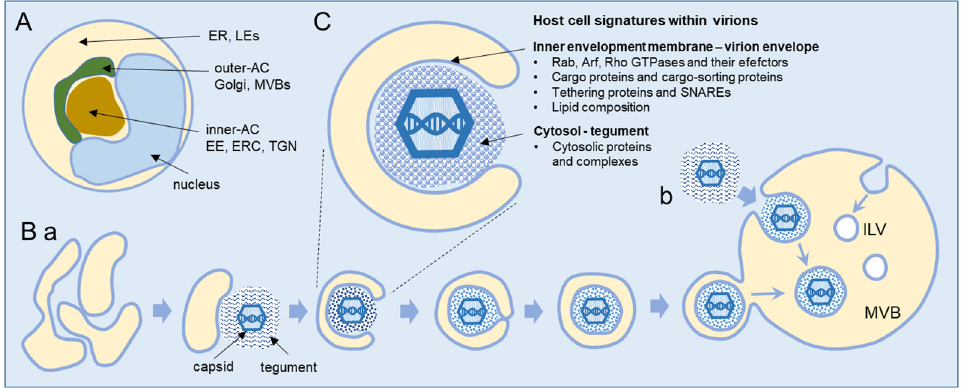
Figure 1. Schematic outline of the beta ‐ herpesvirus secondary envelopment. ( A ) Schematic presen ‐ tation of the infected cell and the AC. ( B ) Suggested sequence of HCMV cytoplasmic maturation in human foreskin fibroblasts recorded by advanced electron microscopy [2,34]. Secondary envelop ‐ ment occurs when partially tegumented capsids contact the membranous compartment. This con ‐ tact deforms the membrane, which wraps around the tegumented capsids and fuse to form envel ‐ oped capsids within the double membrane (a), or capsids bud into a large compartment resulting in fission of enveloped capsids into the lumen (b). At a later stage of infection, capsids were observed in large vacuoles, and HCMV virions may incorporate into multivesicular bodies (MVBs). ILVs, intraluminal vesicles. ( C ) Host cell signatures that may be captured into virions during the envel ‐ opment process.